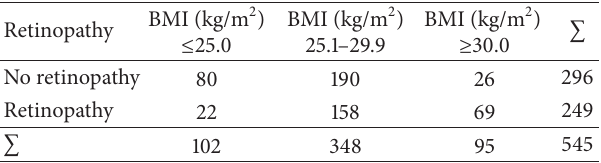
Table 6: Diabetic retinopathy in type 2 diabetic patients ( 𝑛 = 545 ) divided into three groups according to their body mass index